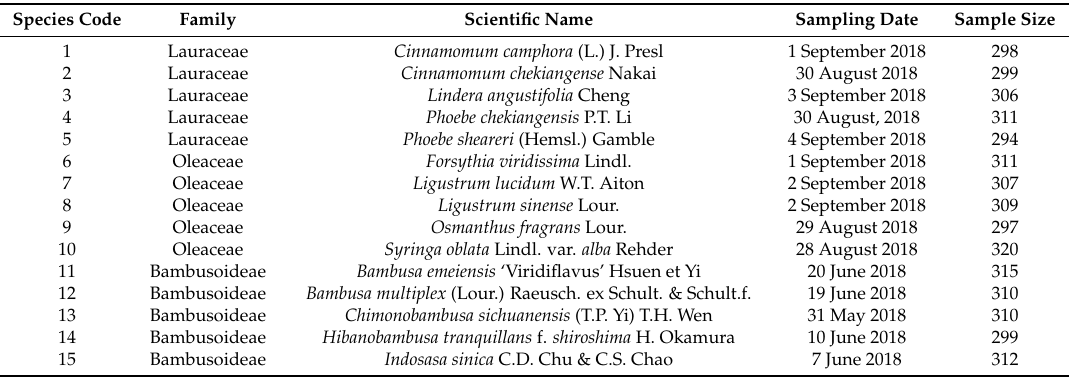
Table 1. Leaf collection information of 15 species of plants that grow in Nanjing Forestry